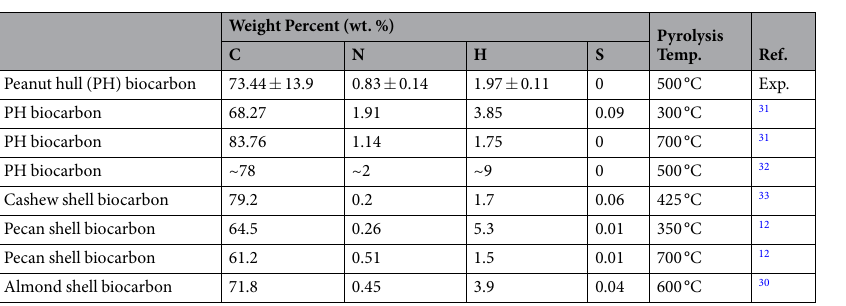
Table 3. Elemental composition of biocarbon from nut